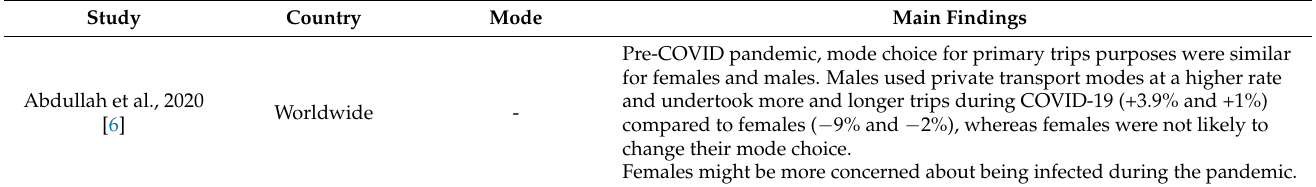
Table 3. Reviewed studies related to COVID-19 impacts on the mobility and activities of different